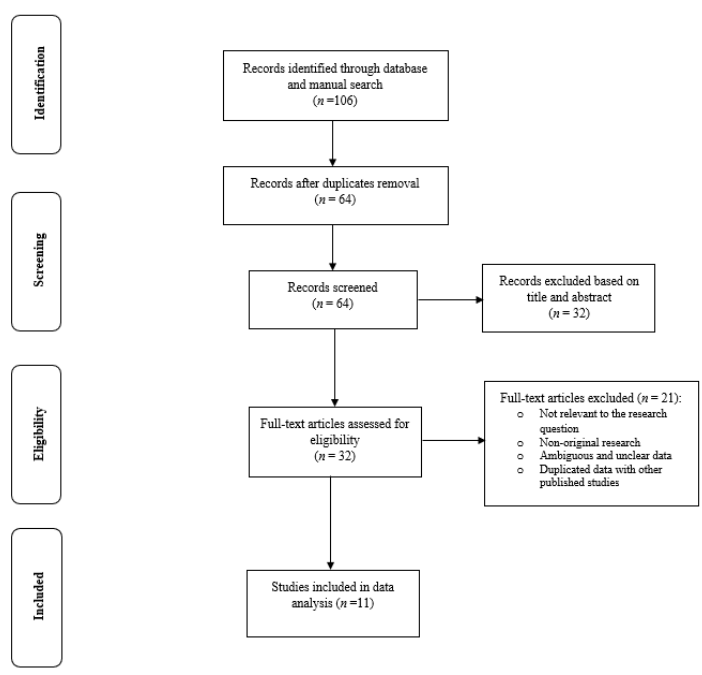
Figure 1. Flow diagram of the study process.